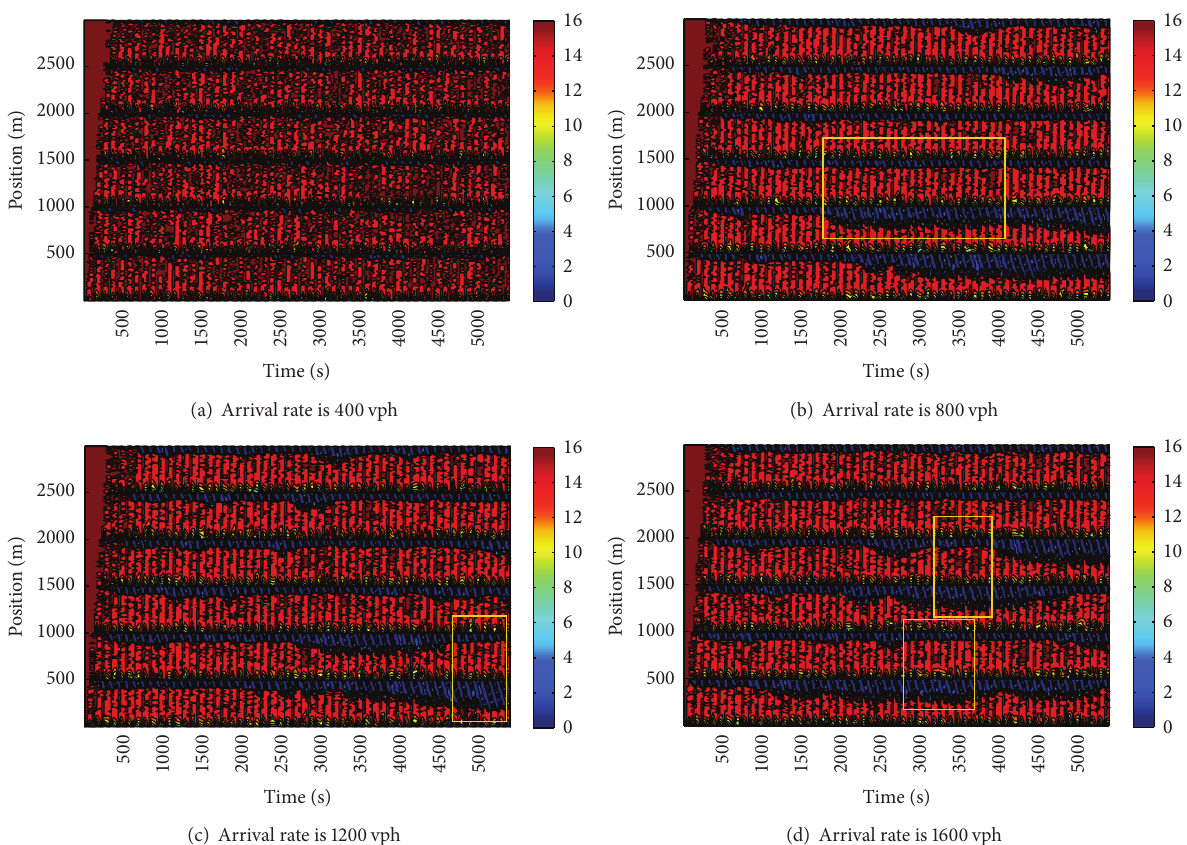
Figure 6: Speed contour plot in synchronized traffic